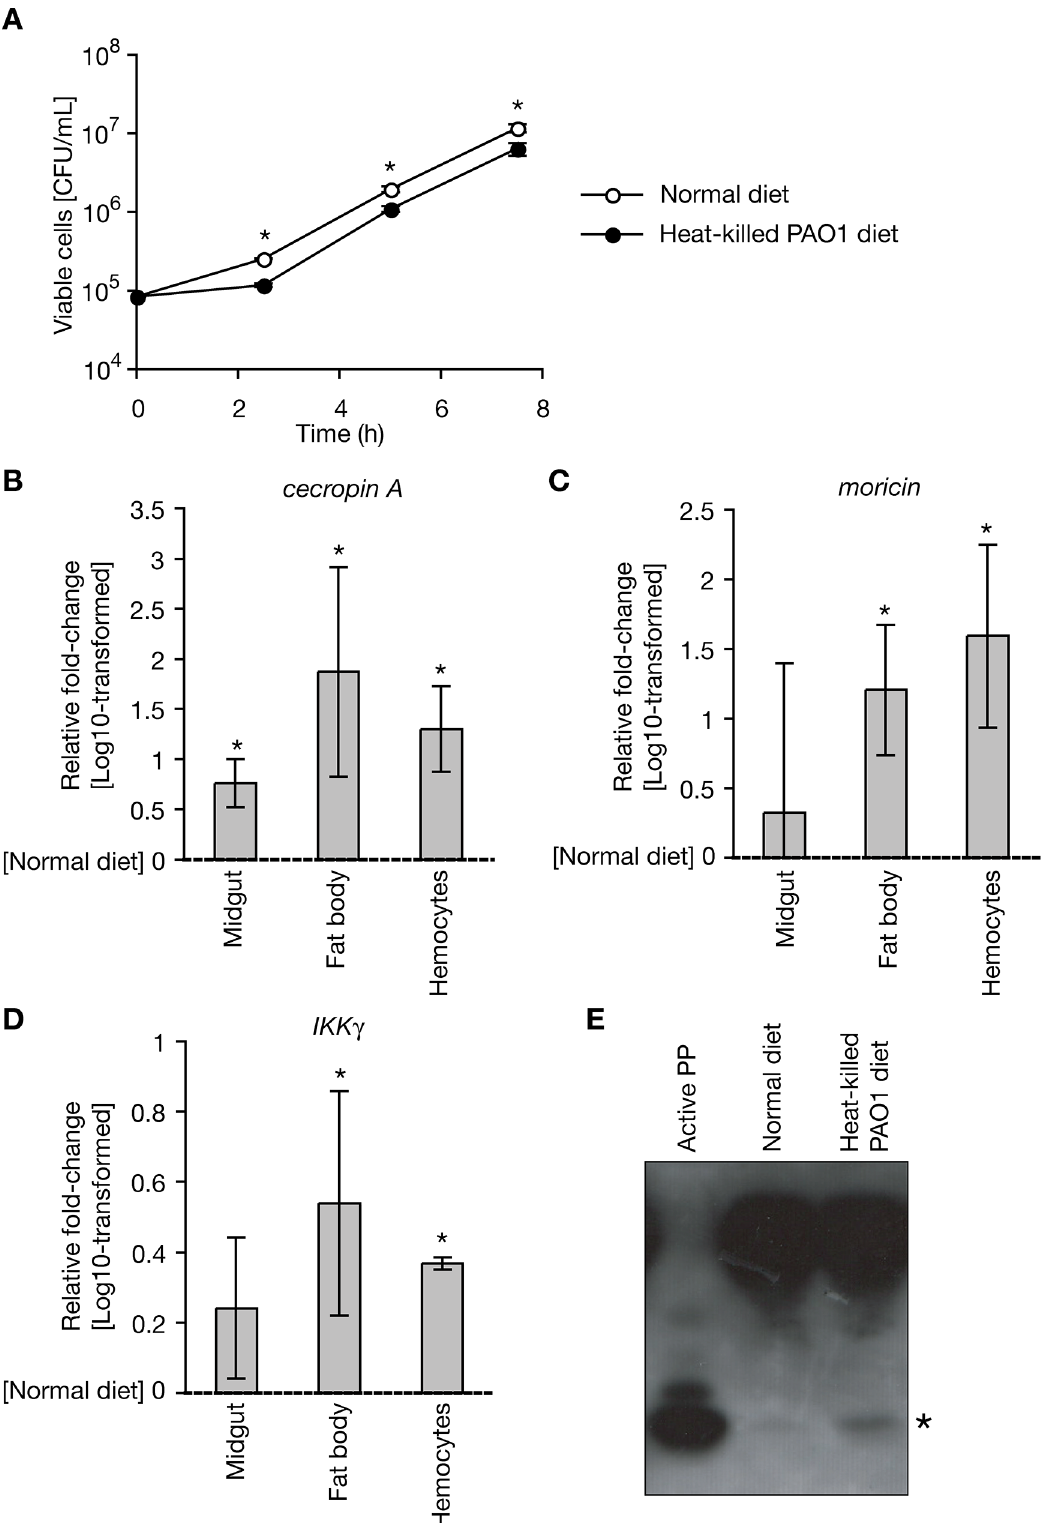
Fig 5. Activation of systemic immunity in silkworms by oral administration of heat-killed P . aeruginosa . A. Hemolymph samples were collected from fifth instar silkworms (n = 3) fed a diet containing heat-killed P . aeruginosa cells for 23 h, and living P . aeruginosa was inoculated into the hemolymph and